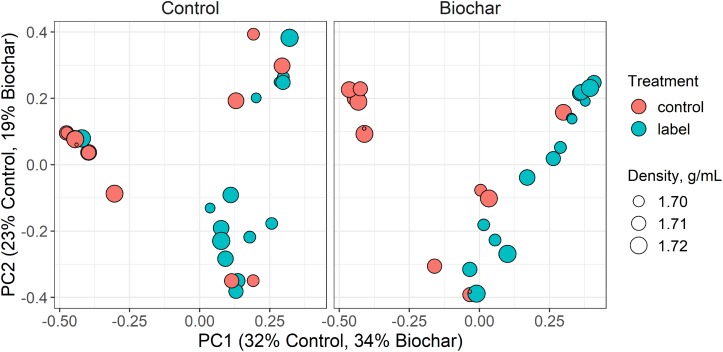
Principal coordinate ordinations (PCoA) ordination based on Bray-Curtis dissimilarities of operational taxonomic units (OTUs) in the heavy (>1.70 g ml–1) gradient fractions of the control and biochar treatments. The size of the density legend represents the range of gradient fraction OTU profiles. The size of a point corresponds to its fraction density, while the distance between points represents the similarity in microbial community composition.